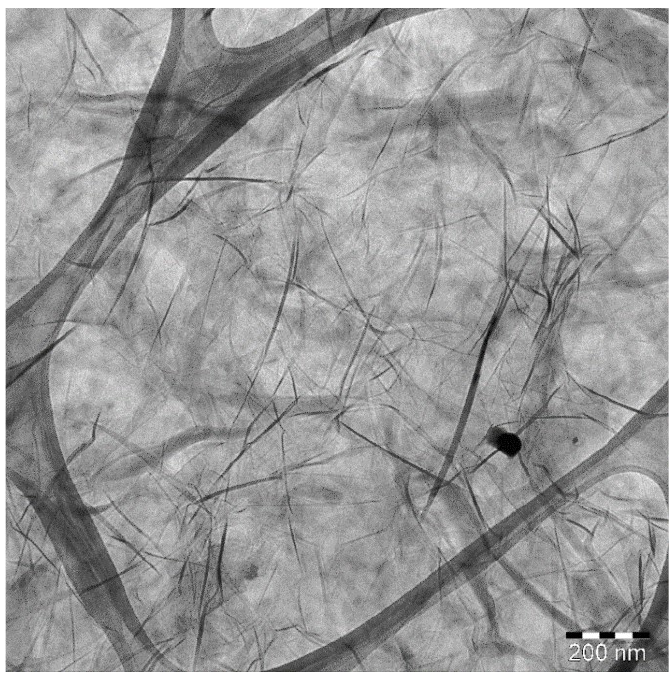
Figure 6. High-resolution transmission electron microscopy (HRTEM) image of NDG.